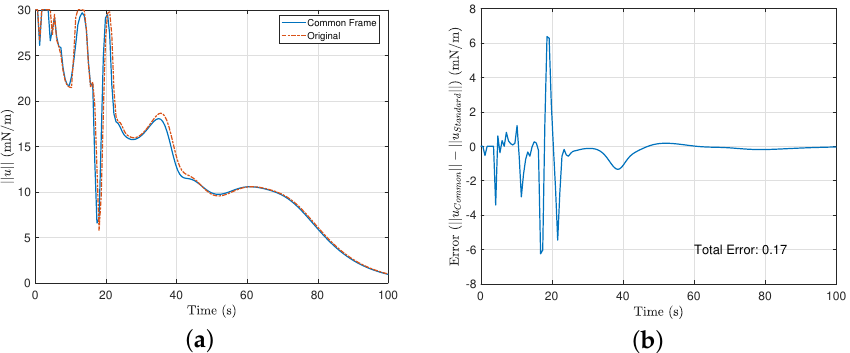
Figure 13. ( a ) is the Control Effort Norm in the Standard and the common frame in the transient time. while ( b ) is the error plot between the common frame and the original formulation.